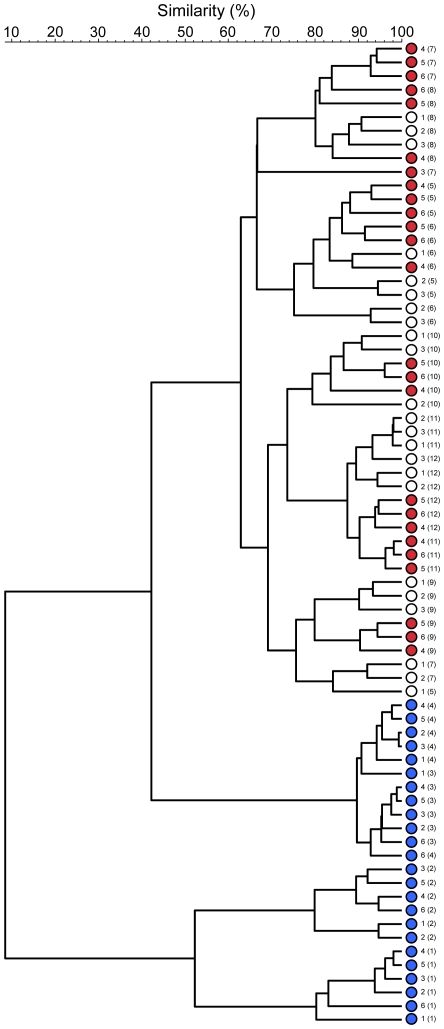
Effect of relocation on the GTM profiles of highly immunocompromised SCID mice (UPGMA cluster analysis of fecal DGGE profiles).All animals were housed in environment A until 8 weeks of age. Samples obtained during this period are designated by blue symbols. Red symbols represent fecal samples obtained from animals that remained in the original environment (A) (sampled in the animals over 8 weeks of age); open symbols represent animals relocated to environment B. Numbers indentify individual animals; numbers in parenthesis give the age of animal in weeks.